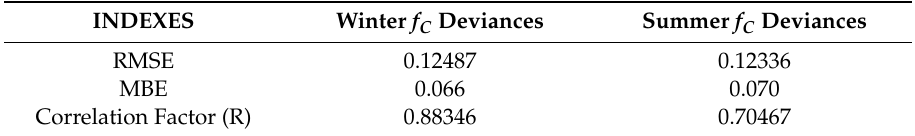
Table 3. Some statistical indexes to quantify the deviations detected between modeled correction factor ( f C ) and observed data for the considered heat pump, both in heating and cooling modes. RMSE: root mean square error. MBE: mean bias